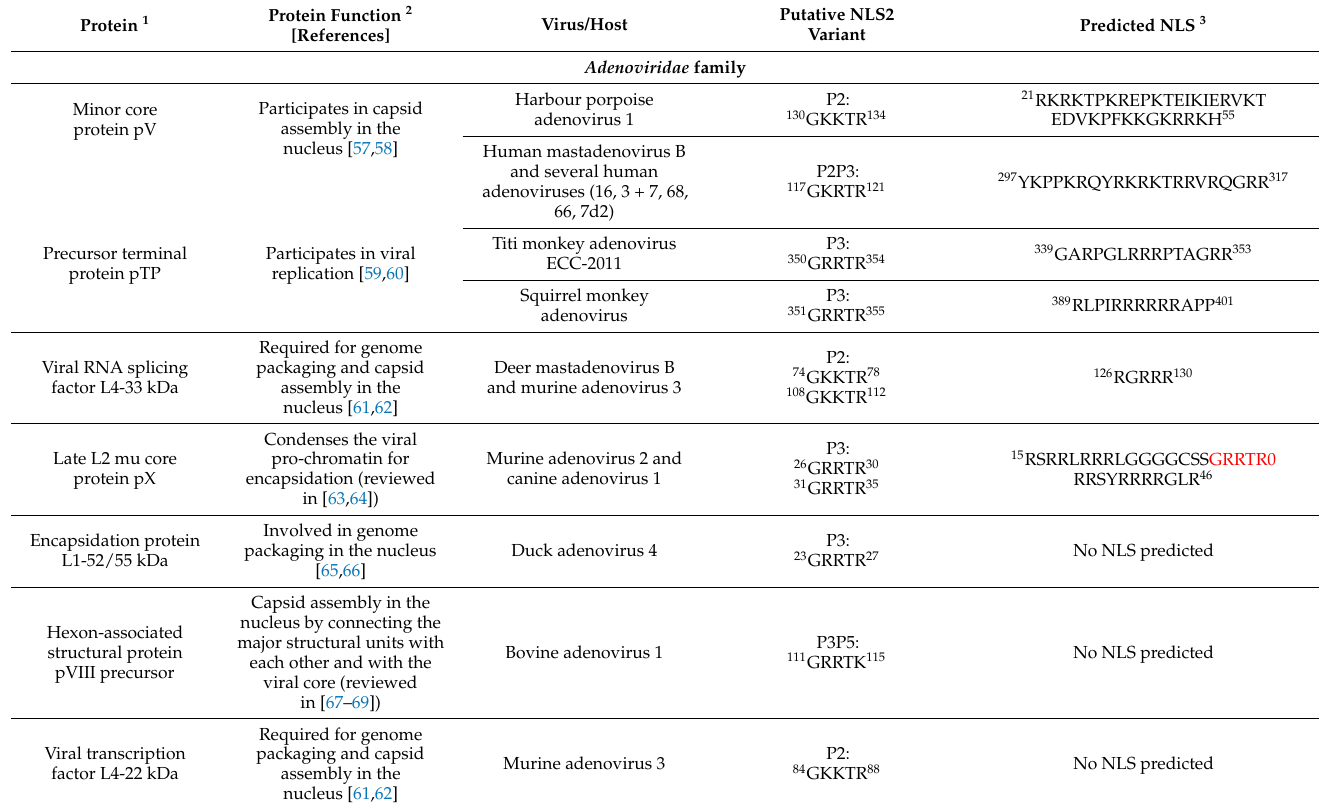
Table 3. Viral proteins from DNA virus families containing variants of the sequence GRKTR and their predicted